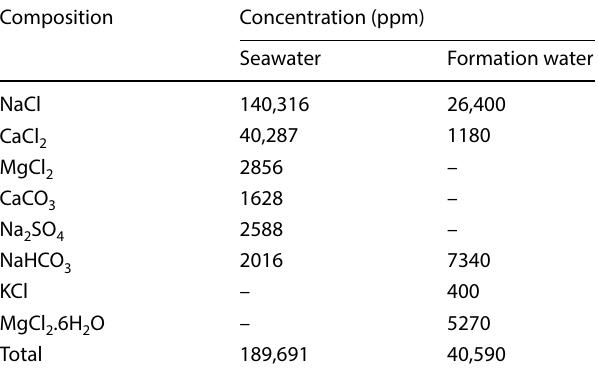
Table 5 Chemical composition of formation water and seawater samples